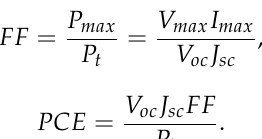
Figure 5. J−V characteristics of the n-i-p PSC . Table 4. History of parameters of the simulations obtained in the solar cells.